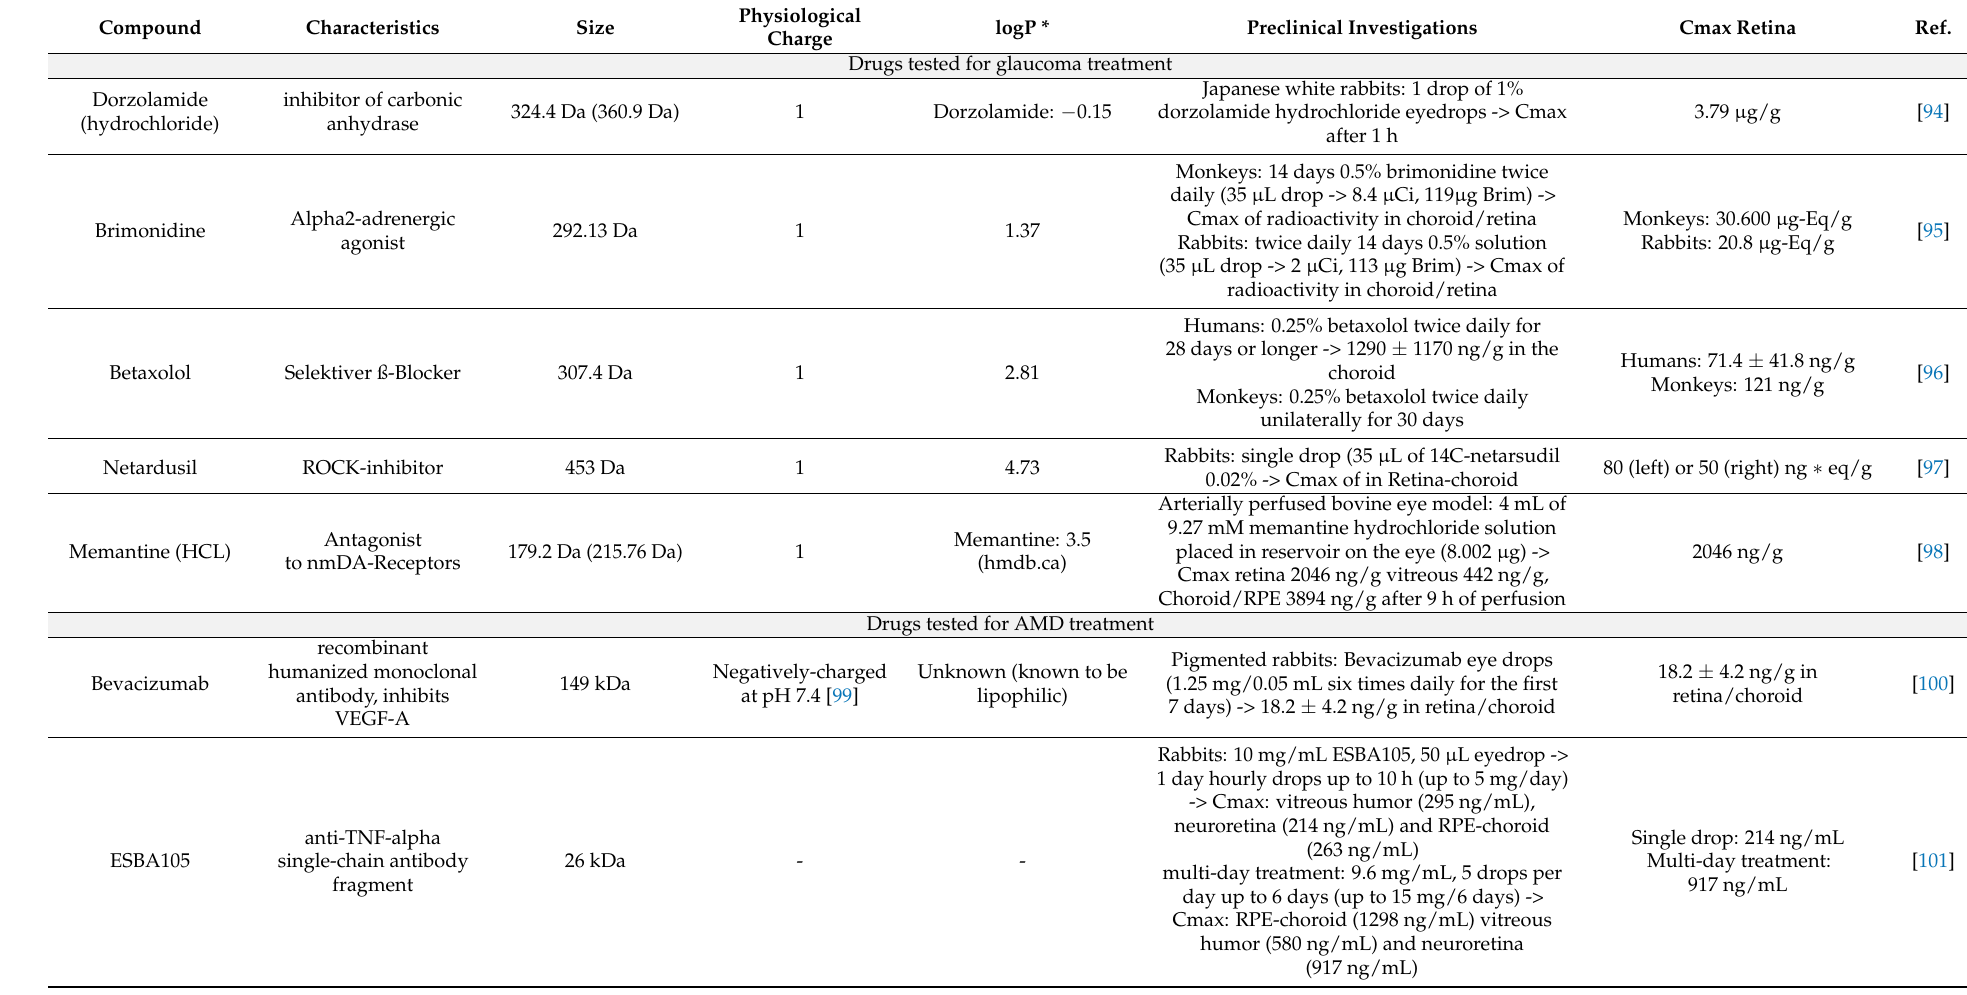
Table 3. Overview of topically applied drugs reaching the posterior segment in preclinical